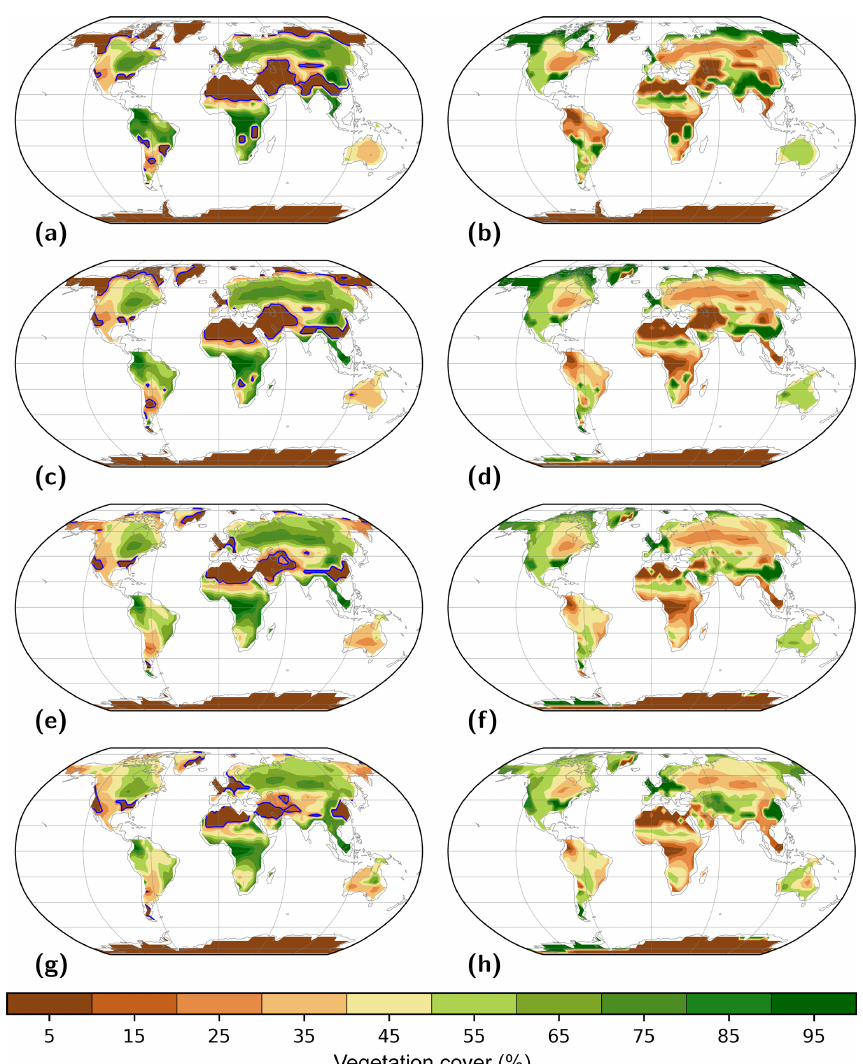
Figure 25. Simulated distribution of vegetation for forest-related (a, c, e, g) and grass-related (b, d, f, h) plant functional types (PFTs) for modern and mid-Pliocene geography and various concentrations of carbon dioxide. Shown are E280 ( a, b ; for reference), Eoi280 (c, d) , Eoi400 (e, f) , and Eoi560 (g, h) . The presence of forest and grass vegetation is quantified by the respective coverage (%) of a grid cell. Forest includes JSBACH tree PFTs 1–4 (tropical evergreen, tropical deciduous, extratropical evergreen, extratropical deciduous); grass includes JSBACH PFTs 5–8 (raingreen shrubs, deciduous shrubs, C 3 grasses, and C 4 grasses). In maps of forest vegetation the location of the tree line is illustrated by the blue contour. Here, we arbitrarily define the tree line to be equivalent to the 15% isoline of forest